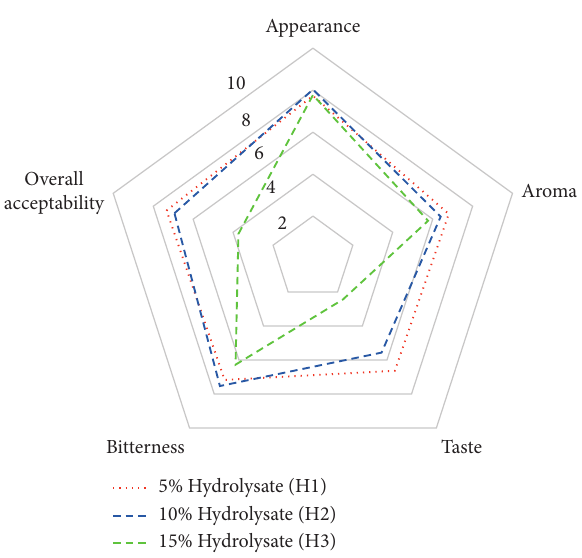
Figure 3: Sensory analysis of spent hen meat hydrolysate powder